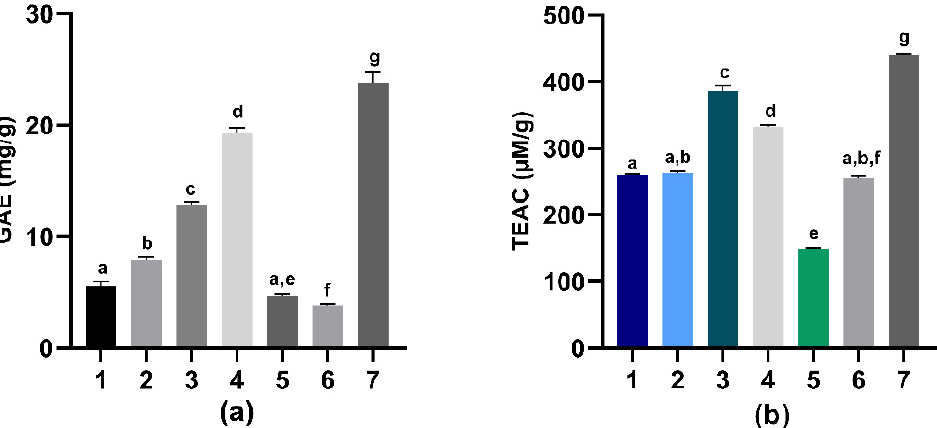
Figure 7. Antioxidant potential of the edible plant organs from Solanum nigrescens ( 1 ), Sechium edule ( 2 ), Rumex obtusifolius ( 3 ), Amaranthus hybridus ( 4 ), Piper auritum ( 5 ), Rhamnus pompana ( 6 ), and Yucca aloifolia ( 7 ). The total phenol content expressed in Gallic Acid Equivalents ( a ) and the antioxidant capacity expressed in Trolox Equivalents ( b ) are shown. Different letters indicate means ( n = 15) with statistically significant differences by ANOVA–Tukey’s test at p < 0.05. Detailed information can be found in Table S6.